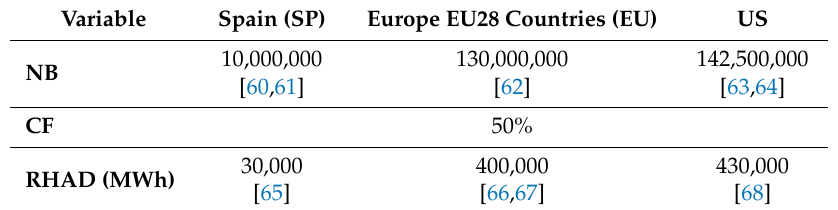
Table 2. Region and country specifics for hourly aggregated demand coverage calculation.